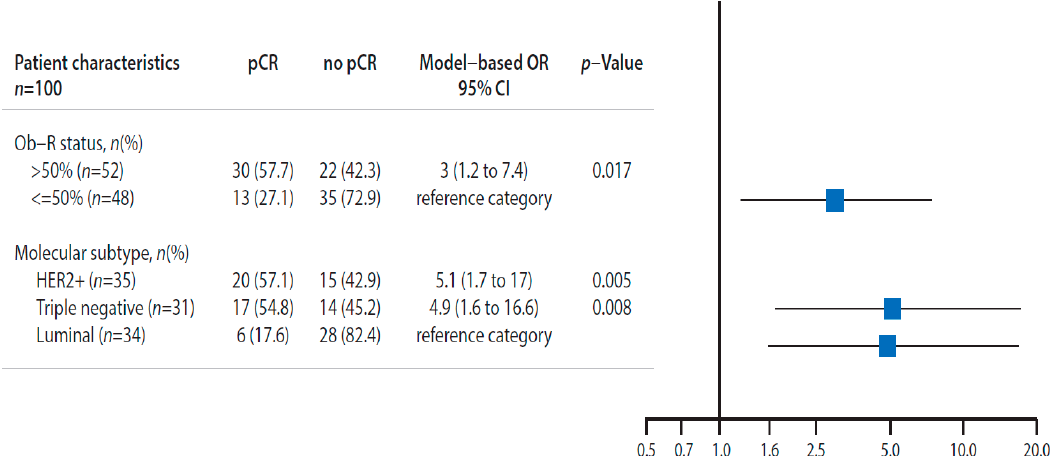
Figure 2. Pathological complete response in accordance with Ob-R cell overexpression (>50%). Ob- R: Leptin receptor, pCR: pathological complete response.